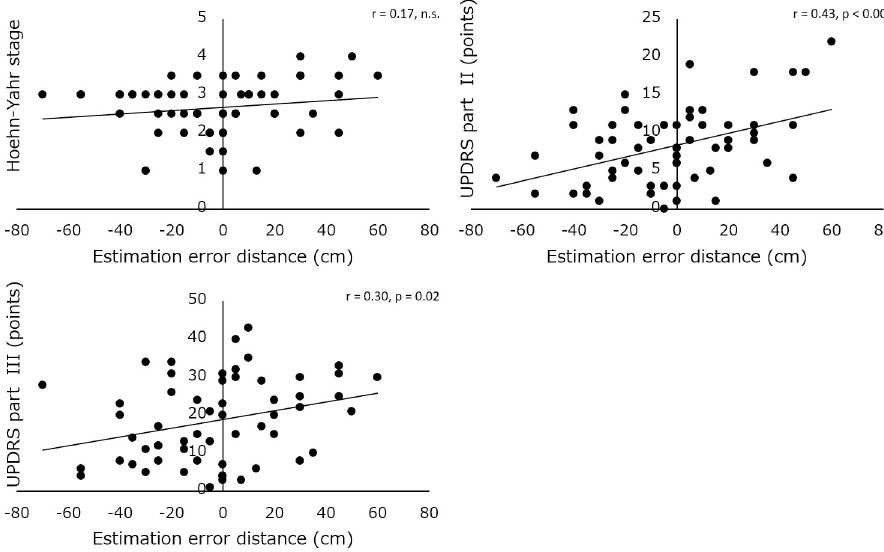
Fig 2. Scattergrams of the estimation error distance, and H&Y stage (upper left), and UPDRS part II (upper right) and III